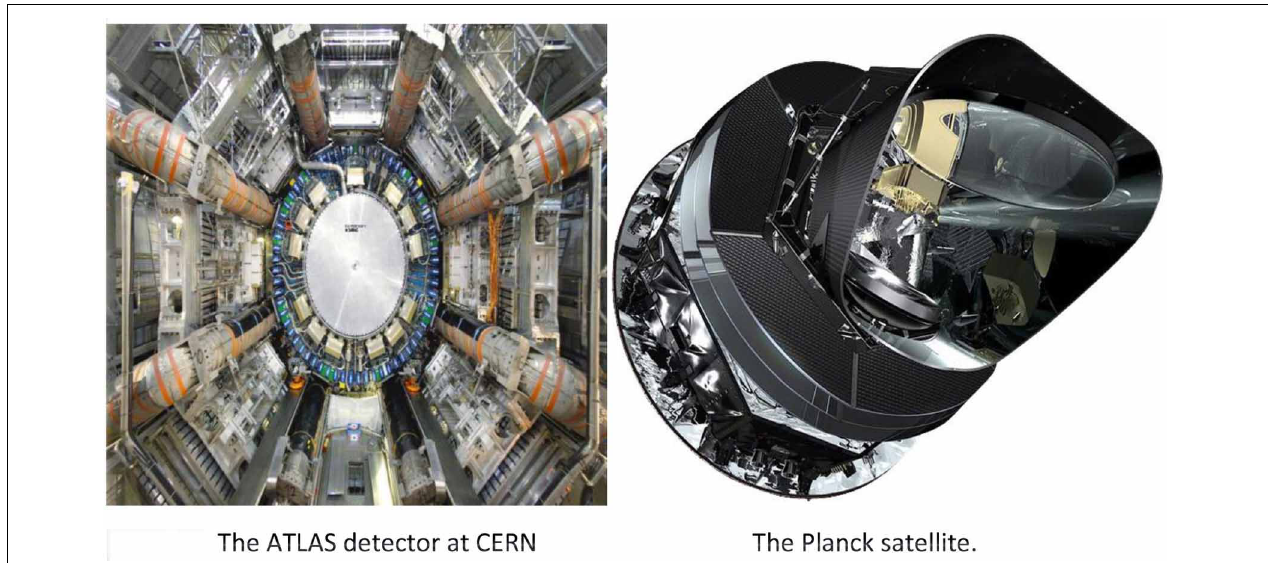
FIGURE 1 | Illustrative views of the ATLAS detector and Planck satellite instrument.